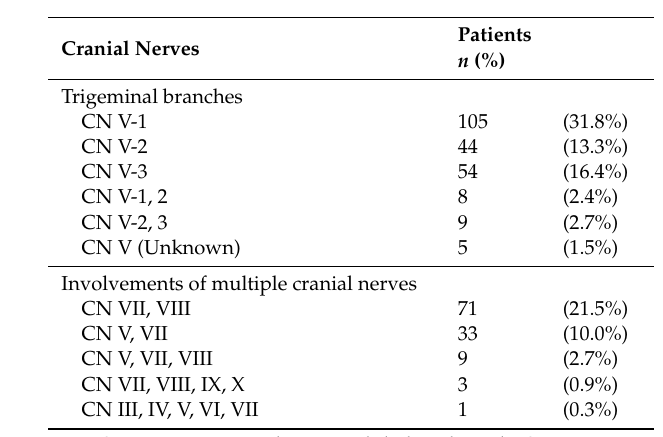
Table 2. The involvements of trigeminal branches and multiple cranial nerves in 330 patients with herpes zoster infection.